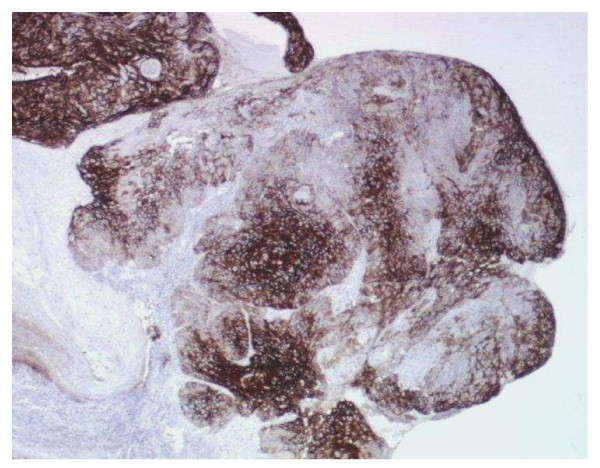
Example of immunohistochemistry for GLUT-1. Example of biopsy stained for GLUT-1 (×40). This tumor was scored highly positive.